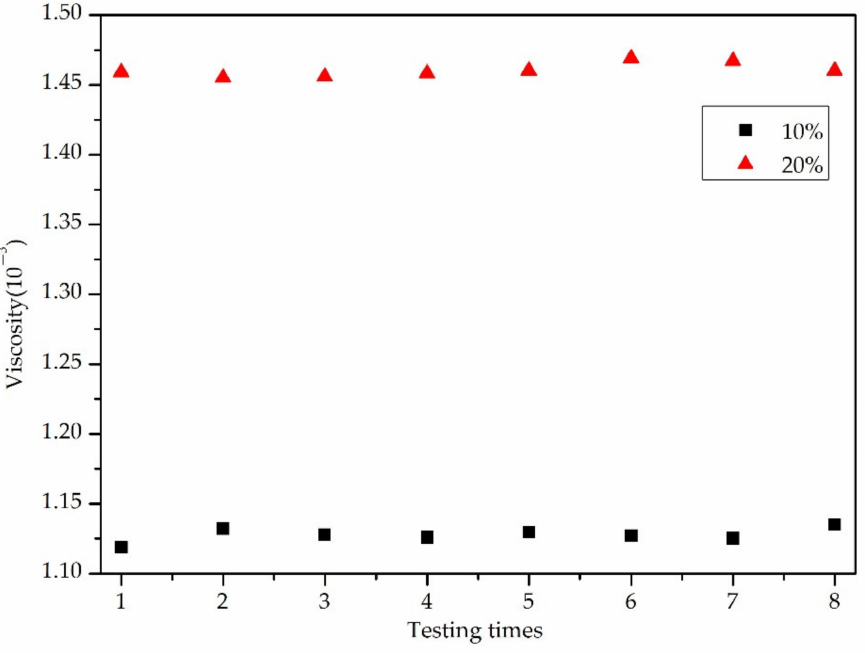
Figure 4. Repeatability experiment (N = 8) of blood viscosity QCM sensor based on impedance analysis